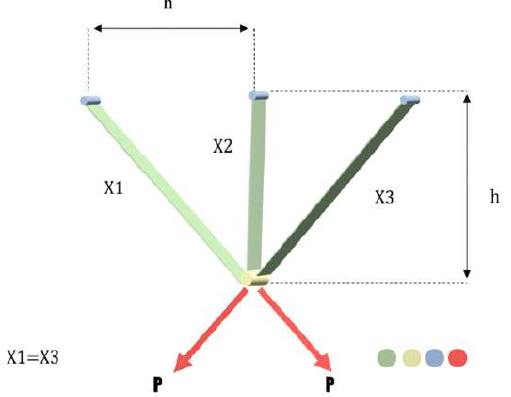
Figure 9. A schematic view of the three-bar truss design problem.